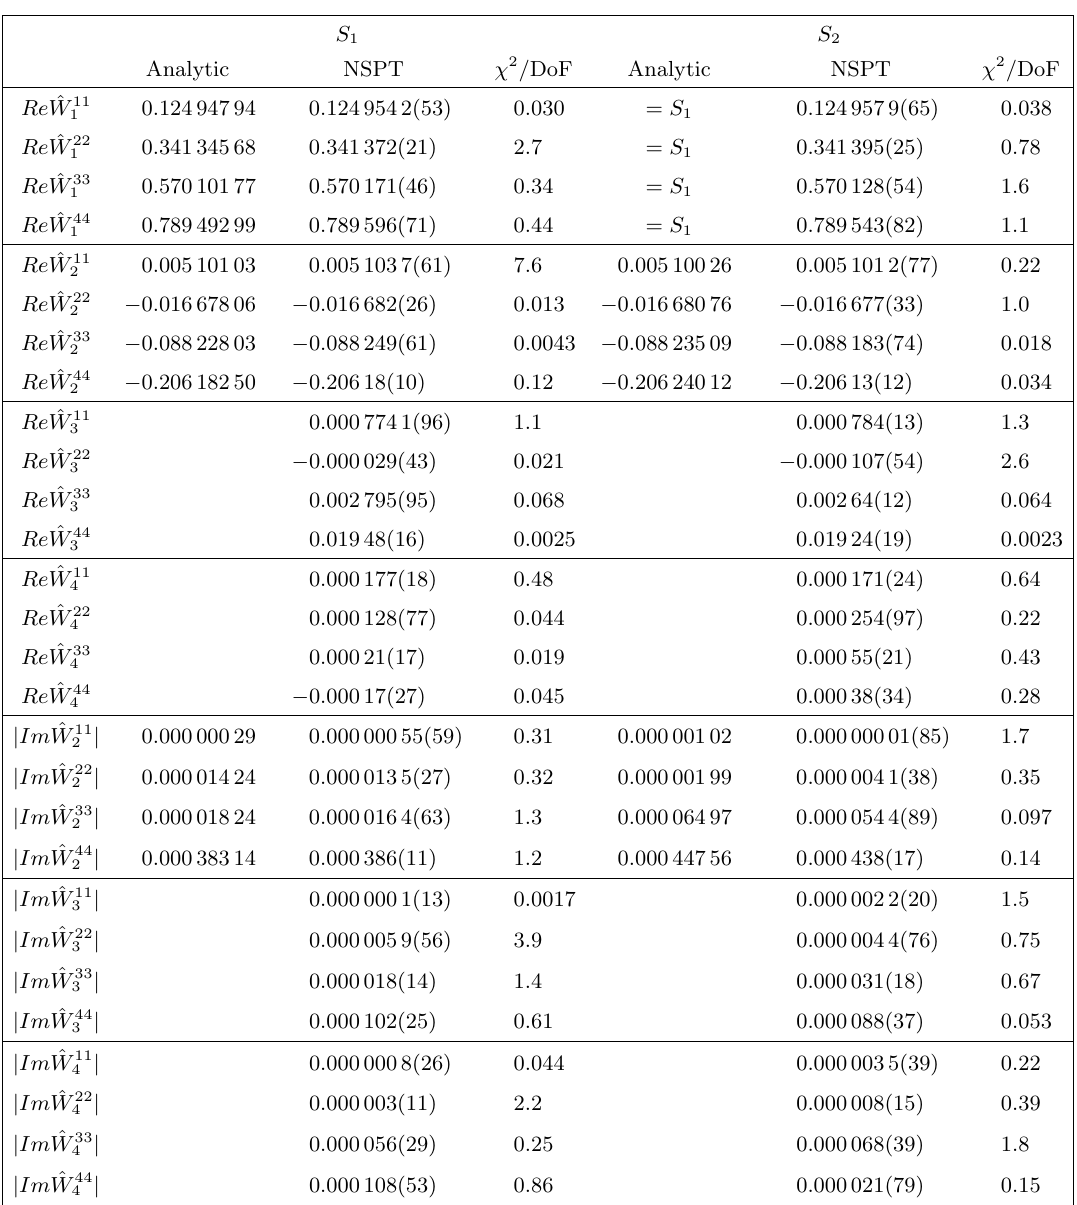
Table 3. Perturbative coe(cid:14)cients for Wilson loops on S 1 ; S 2 planes. (SU(49), k = 2).